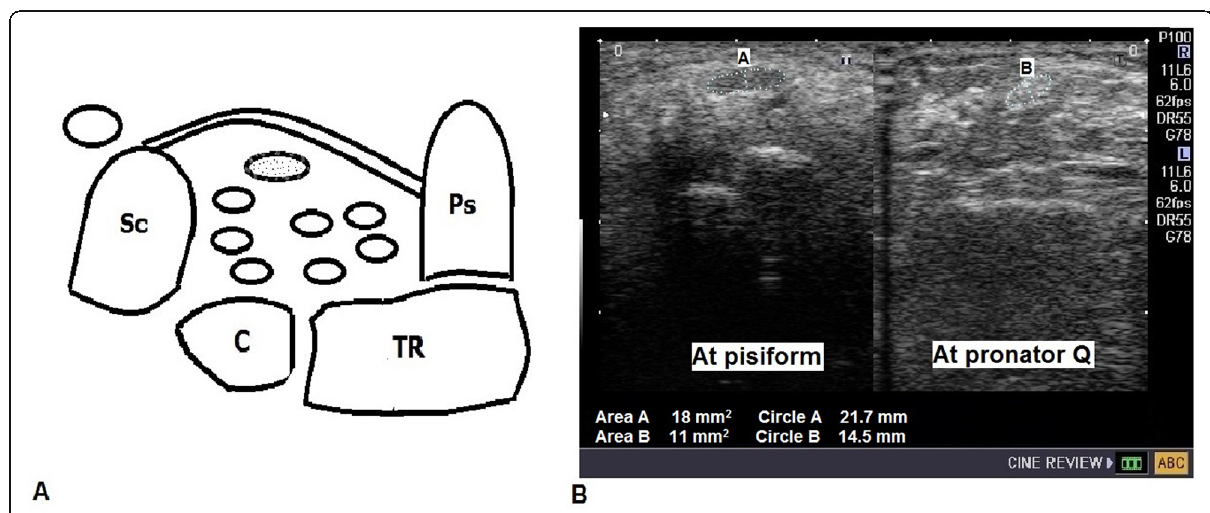
Fig. 1 a Illustration drawing for CSA calculation of the median nerve. b Ultrasonographic cross-sectional area calculation of the median nerve at the level of pisiform bone (area A = 18 mm2) and at the level of pronator quadratus muscle (area B = 11 mm2); CSA difference = (18 − 11) = 7. SC, scaphoid; C, capitate; TR, triquetrum; PS,